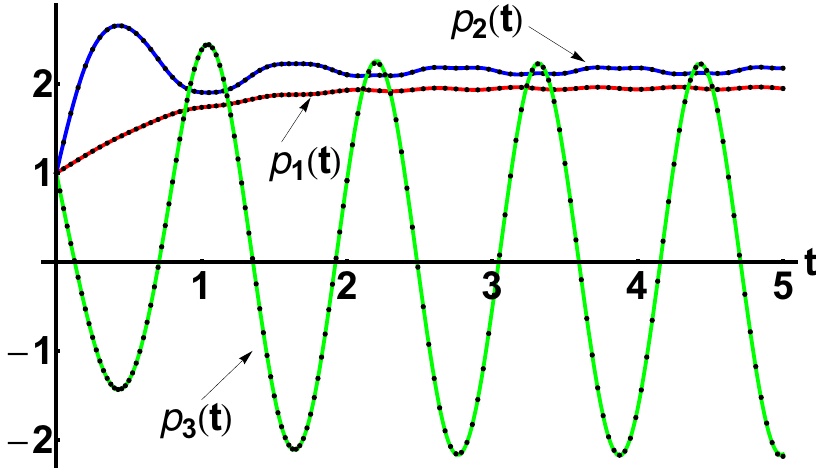
Figure 4: Profiles of the functions ¯ p 1 , ¯ p 2 , and ¯ p 3 respectively, given by Eq. (28), (30), (32) on [0, 2] and Eqs. (29), (31), (33) on [2,